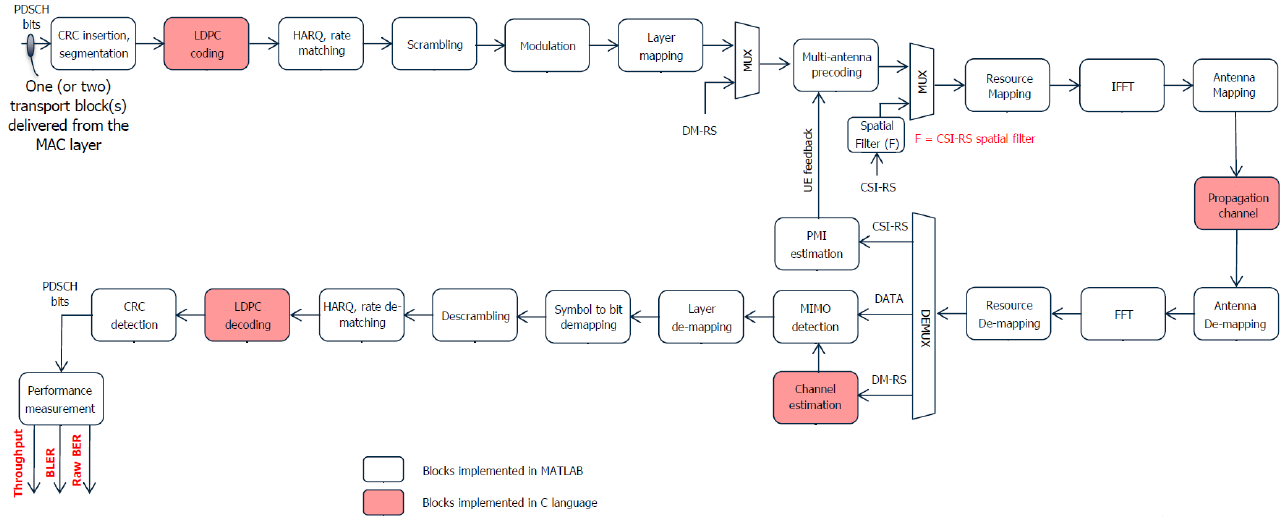
Figure 1. New Radio link-level simulator